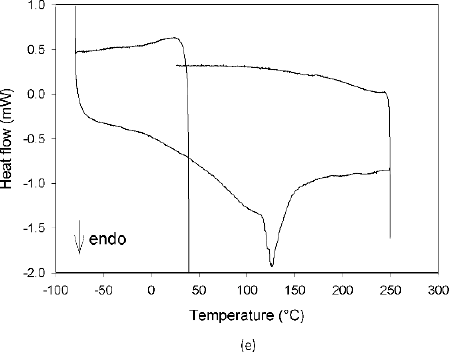
Figure 5. DSC profiles of the mixture MCE-20% AG ( w / w ) after 24 h of degradation at 70 °C-75% RH ( a ), after 4 h ( b ) and 3 days of degradation at 70 °C-30% RH ( c ), and after 3 ( d ) and 7 days of degradation at 25 °C-75% RH ( e ).